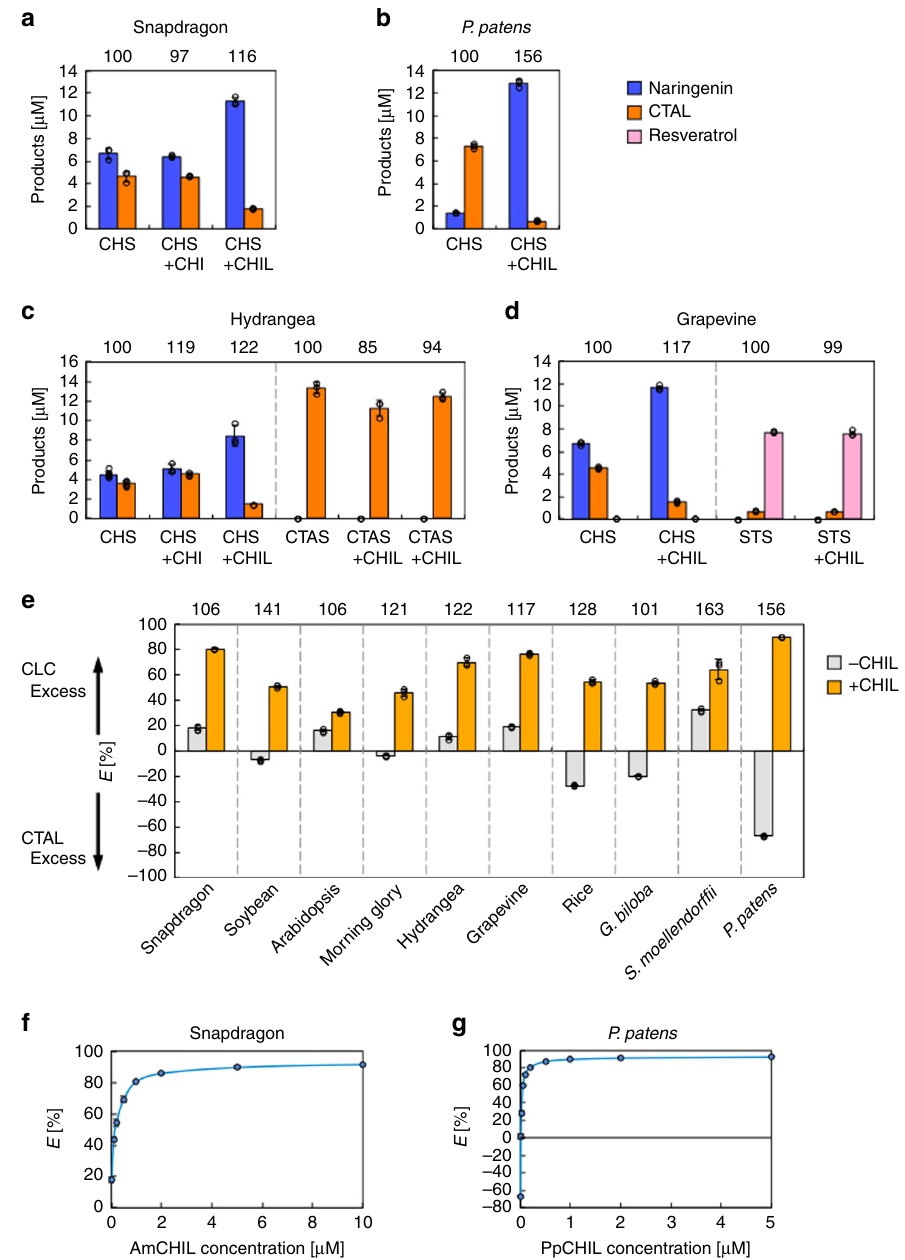
Fig. 5 Effects of CHIL and related proteins on the product speci fi cities of CHS, CTAS, and STS. a Concentrations of products (blue bars, naringenin; orange bars, CTAL) formed after reactions catalyzed by 0.1 µ M AmCHS in the presence and absence of 1 µ M AmCHIL or AmCHI. b Concentrations of products (blue bars, naringenin; orange bars, CTAL) formed after reactions catalyzed by 0.1 µ M PpCHS in the presence and absence of 1 µ M PpCHIL. c Left, Concentrations of products formed after reactions catalyzed by 0.1 µ M HmCHS in the presence and absence of 1 µ M HmCHIL or HmCHI. Right, Concentrations of products formed after reactions catalyzed by 0.1 µ M HmCTAS in the presence and absence of 1 µ M HmCHIL or HmCHI. Blue bars, naringenin; orange bars, CTAL. d Left, Concentrations of products formed after reactions catalyzed by 0.1 µ M VvCHS in the presence and absence of 1 µ M VvCHIL. Right, Concentrations of products formed after reactions catalyzed by VvSTS in the presence and absence of VvCHIL. Blue bars, naringenin; orange bars, CTAL; and pink bars, resvertrol. e E values of reactions catalyzed by CHS (0.1 μ M) in the presence (light-orange bars) and absence (gray bars) of homologous CHIL (1 μ M) in various land plants. For ( a – e ), the numbers above panels indicate the relative percentages of the total amount of polyketide products, with the amount obtained in the absence of added CHIL or CHI set at 100%. f Effects of AmCHIL concentrations on the E values of the reaction catalyzed by 0.1 μ M AmCHS. g Effects of PpCHIL concentrations on the E values of the reaction catalyzed by 0.1 μ M PpCHS. For ( a – g ), enzymatic reactions were completed essentially under standard assay conditions (see Methods). Data are presented as the average of three independent determinations (±standard deviation). The underlying data for ( a – g ) are provided in the Source Data fi